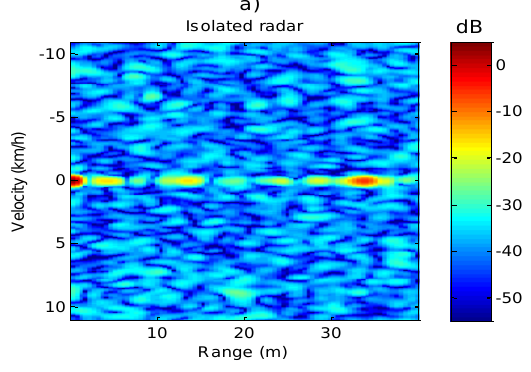
Figure 8. Range-Velocity maps ( a ) single radar ( b ) two non-interfering radars ( c ) two interfering